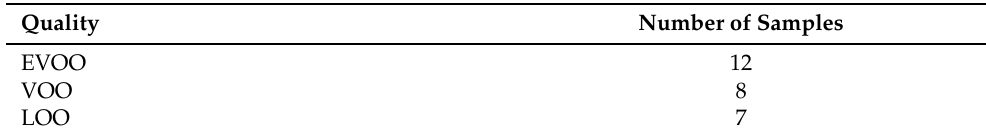
Table 1. The number of olive oils samples in each quality class. EVOO: Extra virgin olive oil, VOO: Virgin olive oil, and LOO: Lampante olive oil.